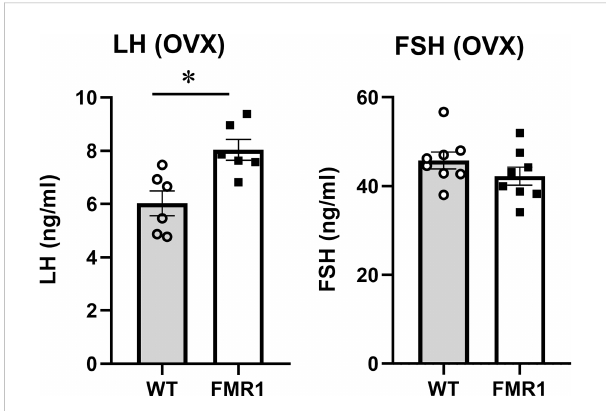
FIGURE 4 Ovariectomized Fmr1 KO mice have higher LH. One week after ovariectomy, LH and FSH samples were collected as in Figure 3. Each point represents one animal, while bars represent group means +/- standard error. Statistical signi fi cance, indicated with a * (p < 0.05) was determined with t-test followed by Tukey ’ s post hoc